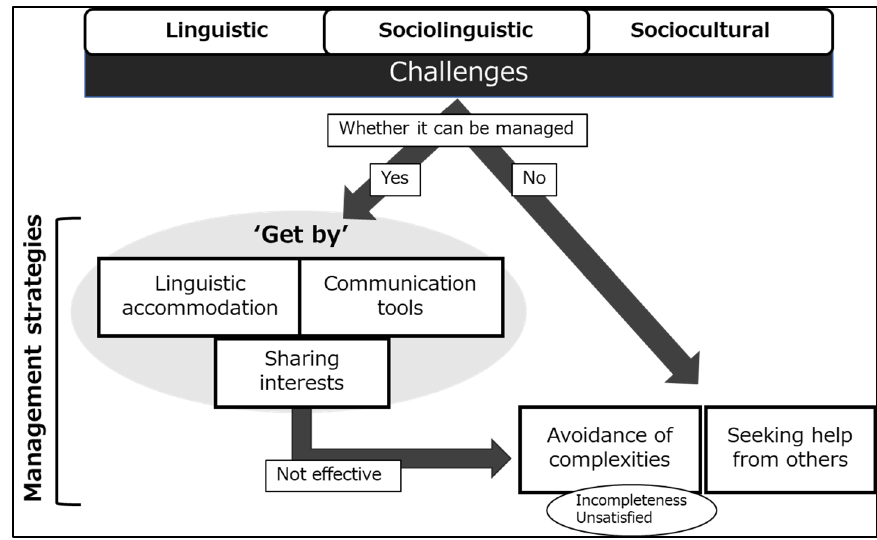
Figure 1. Overview of dentists’ communication management process.